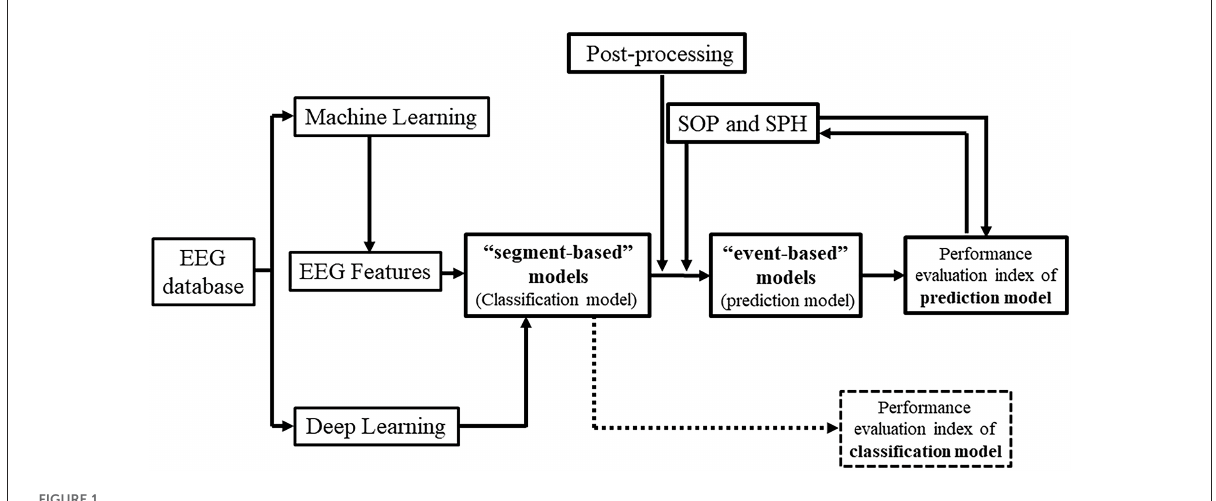
FIGURE1 Flowchart for based-on-EEG seizure